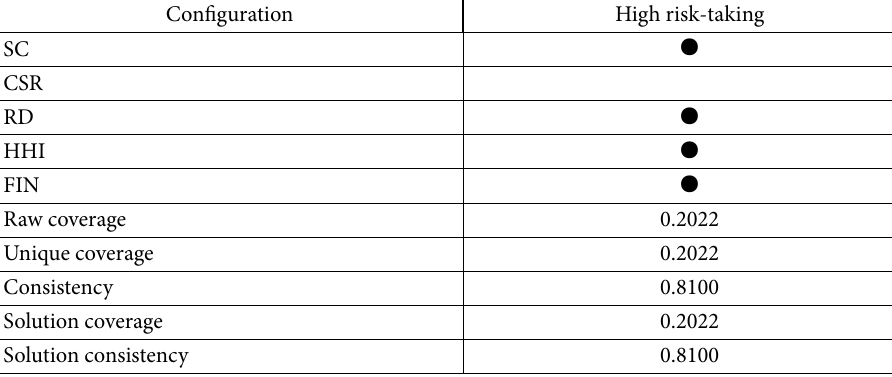
Table 5. Configurations of controls leading to high risk-taking (consistency threshold =